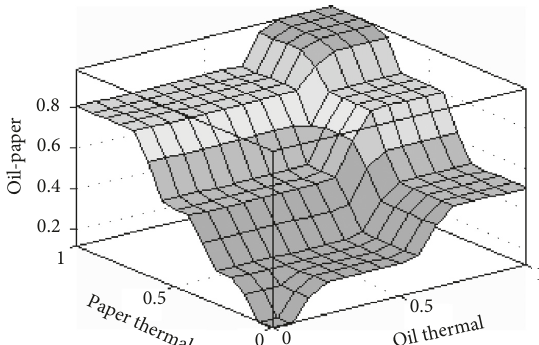
Figure 2: Surface graph-overall thermal fault level.